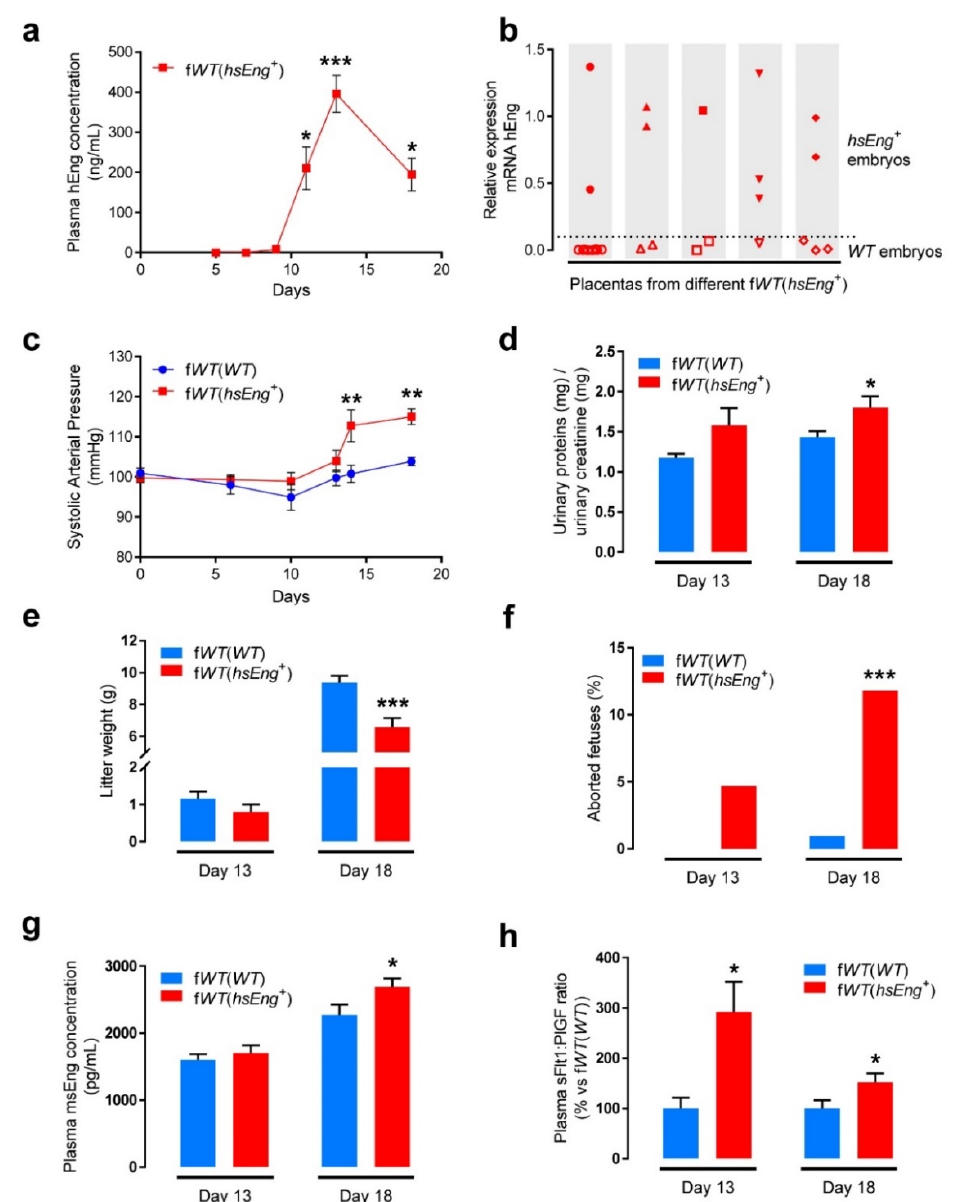
Figure 2. Pregnant f WT ( hsEng + ) mice show high plasma levels of soluble endoglin (sEng) and signs of preeclampsia. ( a ) Plasma levels of hsEng in f WT ( hsEng + ) mice ( n = 6) at different time points during gestation; ( b ) qRT-PCR analysis of hEng mRNA expression in placentas from 5 different f WT ( hsEng + ) mice litters. Each column represents one litter, and each value corresponds to one placenta from that litter. Placentas with higher levels of hEng expressions are inferred to be from hsEng + embryos, whereas placentas with almost no expression are inferred to be from WT embryos; ( c ) Systolic arterial pressure of f WT ( WT ) ( n = 9) and f WT ( hsEng + ) ( n = 12) mice at different time points during gestation; ( d ) Urinary protein excretion, normalized to urinary creatinine concentration, of f WT ( WT ) and f WT ( hsEng + ) at Day 13 (f WT ( WT ) n = 8 and f WT ( hsEng + ) n = 9) and Day 18 (f WT ( WT ) n = 19 and f WT ( hsEng + ) n = 21) of gestation; ( e ) Weight of the litters from f WT ( WT ) and f WT ( hsEng + ) mice at Day 13 (f WT ( WT ) n = 5 litters and f WT ( hsEng + ) n = 6 litters), and Day 18 (f WT ( WT ) n = 18 litters and f WT ( hsEng + ) n = 22 litters) of gestation; ( f ) Percentage of aborted fetuses over total fetuses observed on Day 13 or Day 18 of gestation; ( g ) Plasma levels of murine sEng in f WT ( WT ) and f WT ( hsEng + ) at Day 13 (f WT ( WT ) n = 12 and f WT ( hsEng + ) n = 15) and Day 18 (f WT ( WT ) n = 10 and f WT ( hsEng + ) n = 13) of gestation; ( h ) sFlt1:PlGF ratio in plasma from f WT ( WT ) and f WT ( hsEng + ) mice at Day 13 (f WT ( WT ) n = 6 and f WT ( hsEng + ) n = 7) and Day 18 (f WT ( WT ) n =12 and f WT ( hsEng + ) n = 11) of gestation. Mean ± SEM are displayed. * p < 0.05, ** p < 0.01, and *** p < 0.001 of f WT ( hsEng + ) vs. f WT ( WT